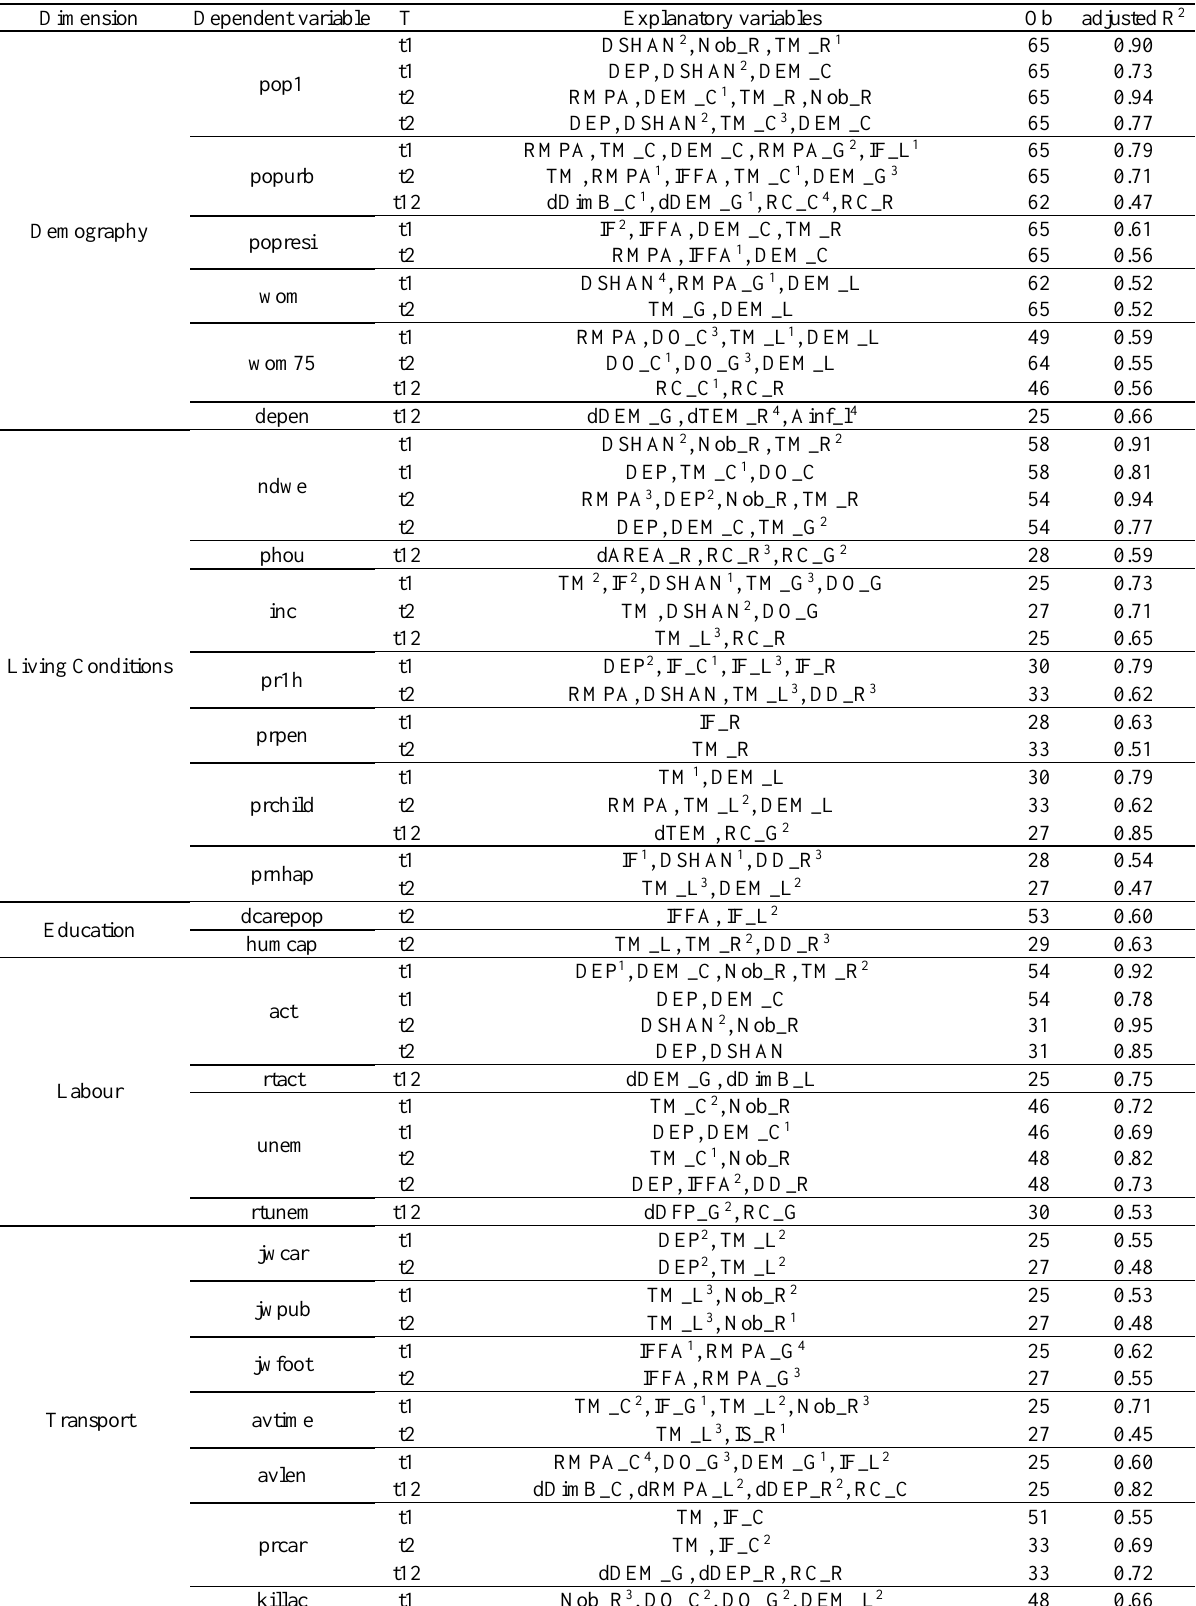
Table 4. List of the regression models between urban fragmentation metrics (explanatory variables) and socio-economic variables (dependent variable). Where t1=2006, t2=2012, t12=2006-2012, Ob=number of observations, and significance codes are: 1 =0.0001, 2 =0.001, 3 =0.01, and 4 =0.05. See Tables 1 and 2 for the label descriptions; labels beginning with “d” mean